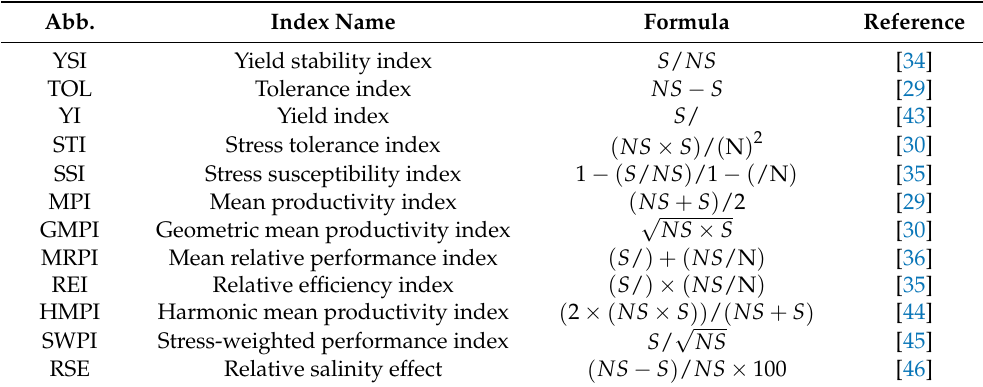
Table 1. The abbreviations (Abb.), full index name, formula, and references of the different stress tolerance indices (STIs) used in this